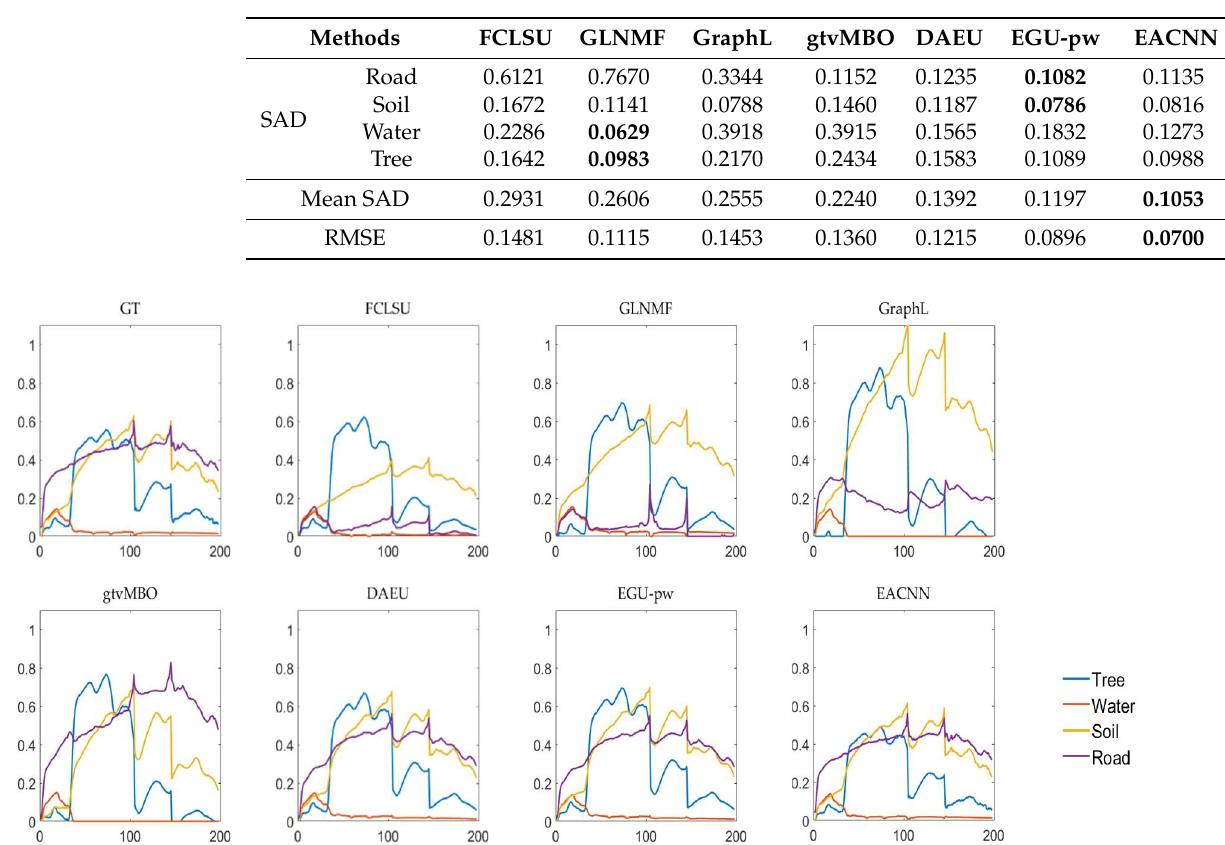
Table 5. Experimental results for the Samson